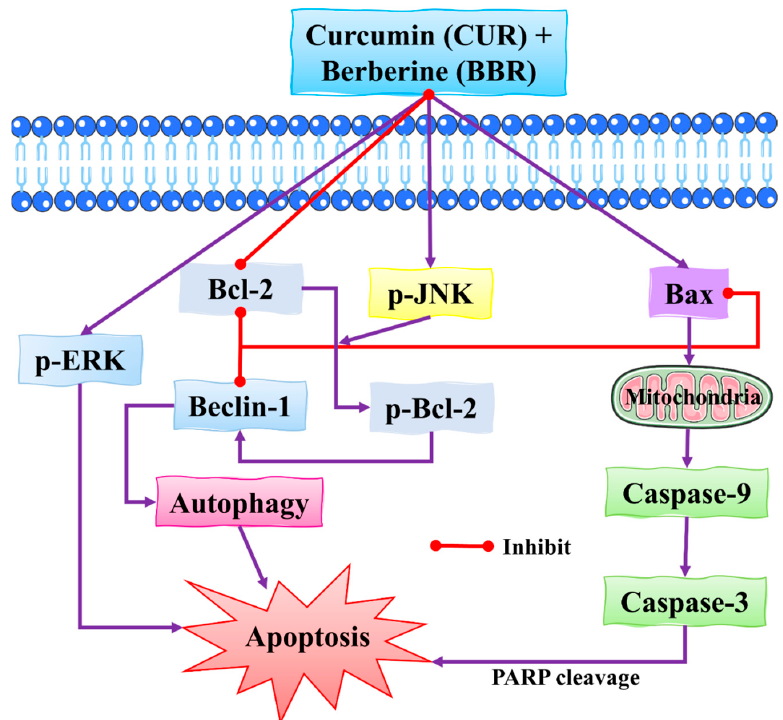
Figure 8. The synergistic effect of CUR and BBR against BC cells by inducing apoptosis. Apoptosis in BC cells is induced by a combination of CUR and BBR, mediated through the activation of the ERK signaling pathway. These two compounds work together to enhance JNK activation, phosphorylation of Bcl-2, and dissociation of the Beclin1/Bcl-2 complex in BC cells, eventually resulting in autophagic cell death. Bcl-2: B-cell lymphoma 2; Bax: BCL2-associated X protein; PARP: poly (ADP-ribose) polymerase; JNK: c-Jun N-terminal kinase; ERK: extracellular signal-regulated kinase. This figure